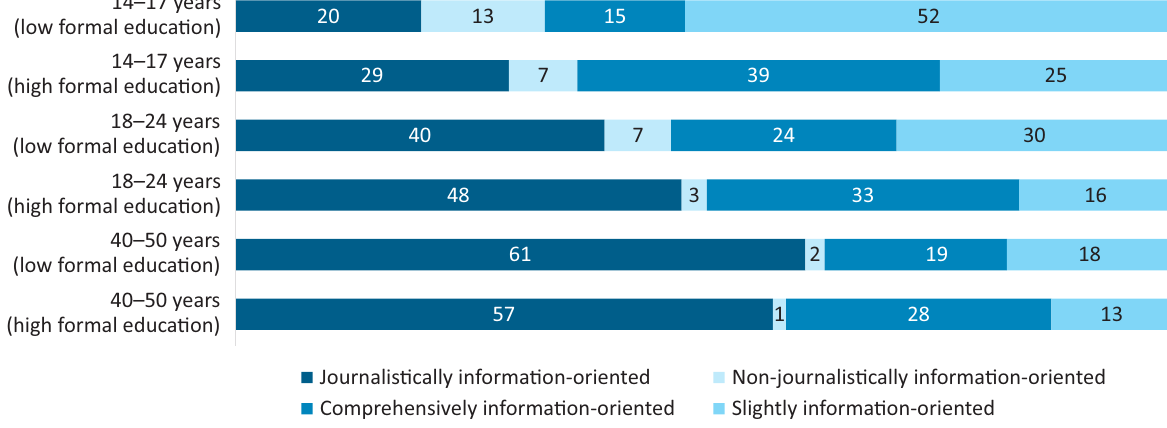
Figure 2. Distribution of types of information orientation by age group and educational level, in %. Notes: 14‐ to 17‐year‐ olds—n = 494; 18‐ to 24‐year‐olds—n = 500; 40‐ to 50‐year‐olds—n =